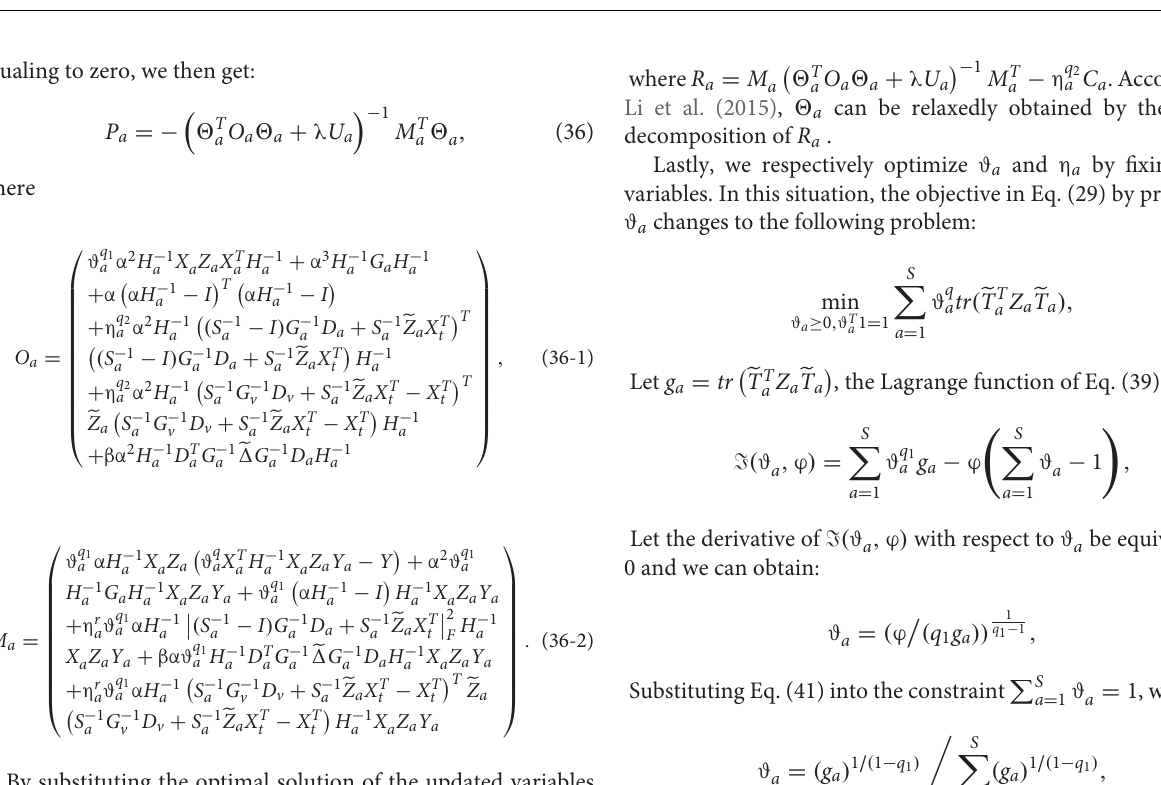
FIGURE 5 | Multi-source adaptation emotion recognition accuracy (SI: Session I, SII: Session II, SIII: Session